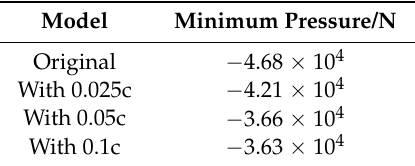
Table 3. The minimum pressure of the original model and the model with leading-edge serrations of different amplitudes.